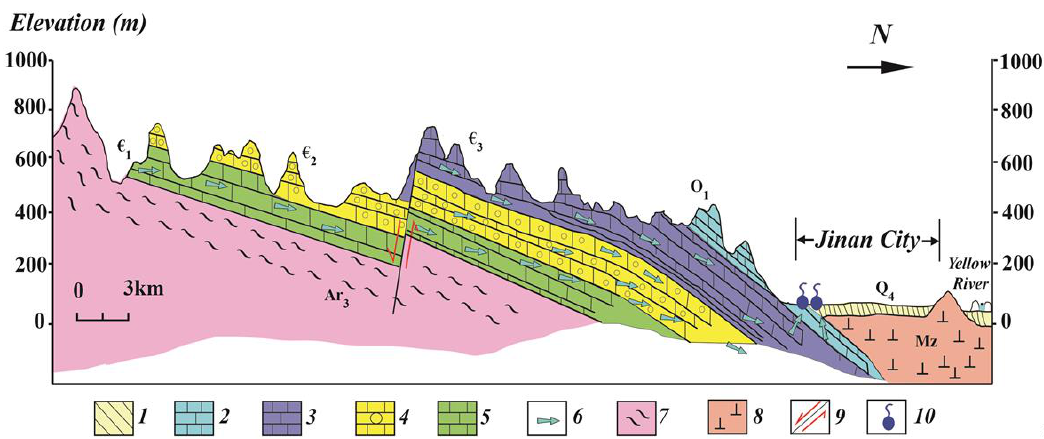
Figure 2. Geological longitudinal section of Jinan spring catchment shows 1—Soil (Q 4 ), 2—Dolomitic limestone (O 1 ), 3—Limestone and shale ( € 3 ), 4—Oolitic limestone ( € 2 ), 5—Limestone and shale ( € 1 ), 6—Flow direction, 7—Granitic gneiss (Ar 3 ), 8—Diorite (M Z ), 9—Fault, 10—Jinan spring groups; (Q 4 is